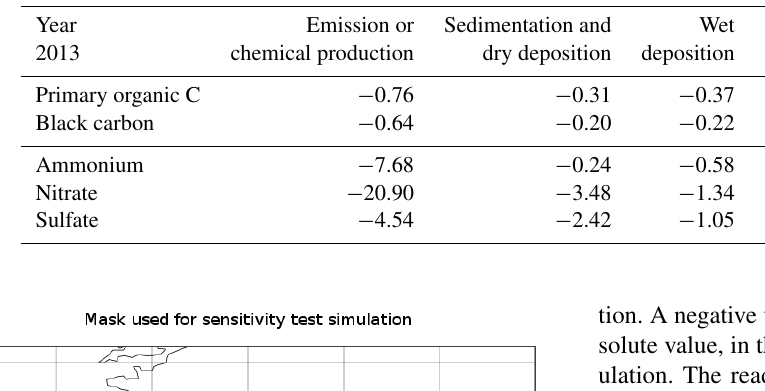
Table 15. Same as Table 14 but for 2013.